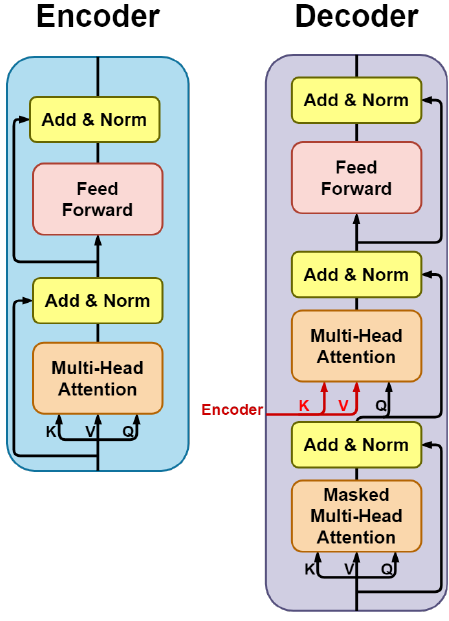
Figure 5. Encoder and Decoder in the Transformer.